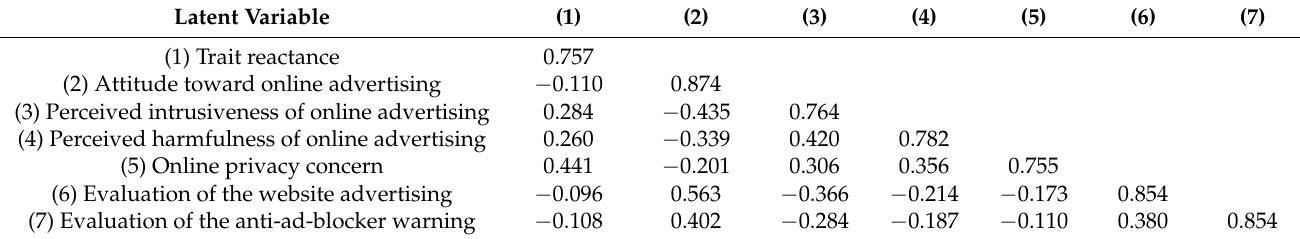
Table 2. Assessment of discriminant